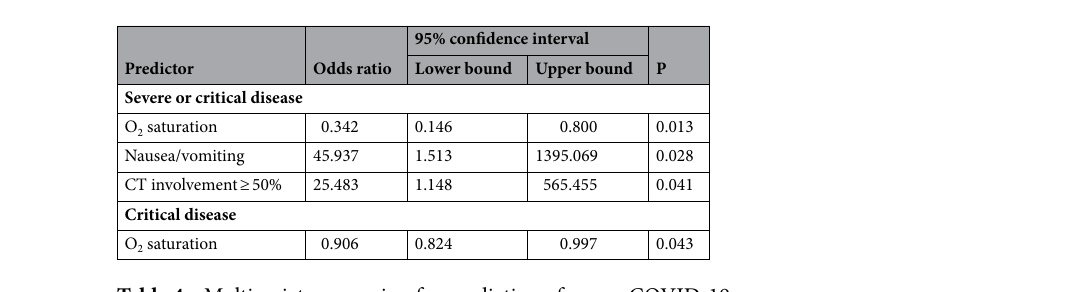
Table 4. Multivariate regression for prediction of severe